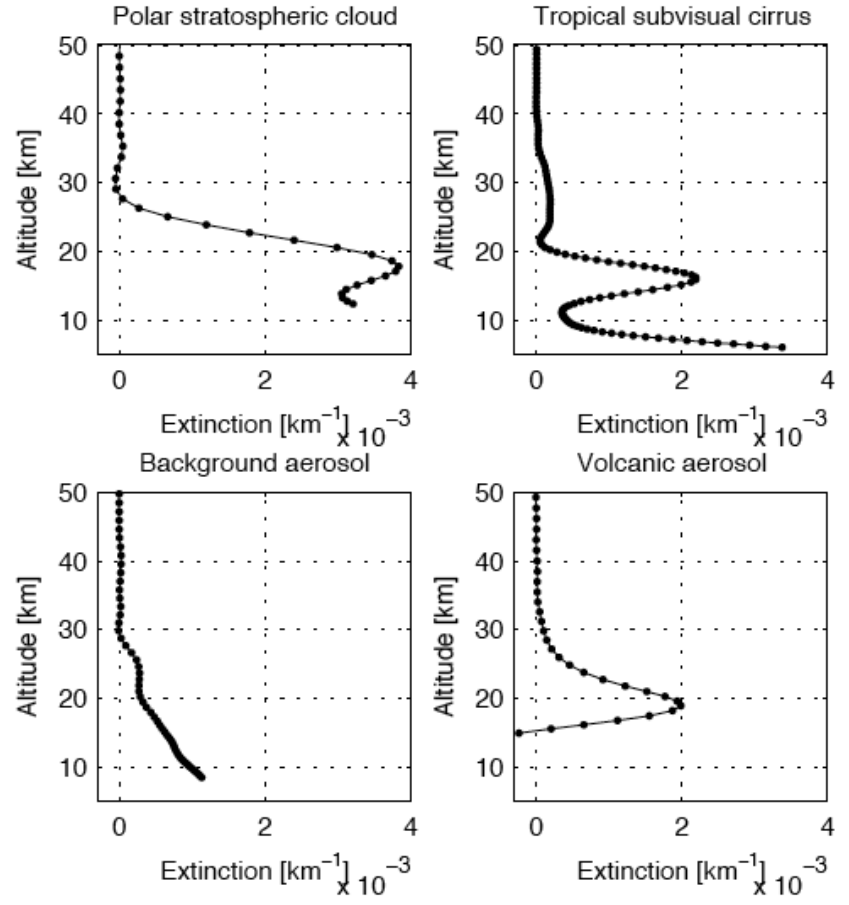
Fig. 44. Individual GOMOS particle extinction profiles: a Polar Stratospheric Cloud (30 July 2003, 72.57 ◦ S, 2.18 ◦ W), a tropical sub-visual cirrus cloud (7 October 2002, 0.52 ◦ S, 78.69 ◦ E), background stratospheric aerosols (12 September 2003, 43.34 ◦ S, 137.36 ◦ W) and volcanic stratospheric aerosols (9 January 2007, 4.52 ◦ S, 27.15 ◦ E). All plots have the same scale, in order to facilitate comparisons of magnitude (from Vanhellemont et al., 2010).